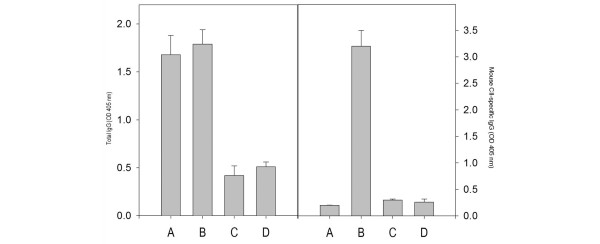
Total and type II collagen-specific IgG levels in DQ6α8β transgenic expressing mice. Sera samples from (a) 10 middle-aged mice with spontaneous polychondritis, (b) from 10 young mice with type II collagen (CII)-induced polychondritis, (c) from 10 young naïve mice not displaying clinical disease or (d) from 10 middle-aged mice not displaying clinical disease were collected and assessed for the levels of total IgG and CII-specific IgG by ELISA. Polychondritic mice had greatly elevated levels of total IgG, but only CII-induced polychondritic mice had elevated CII-specific IgG. OD, optical density.